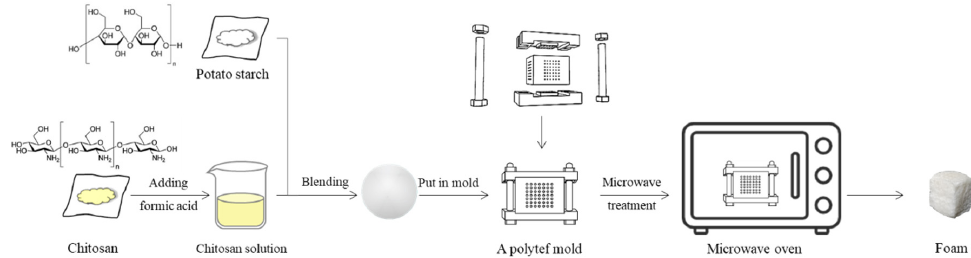
Figure 1. Schematic diagram of preparation of CTS-starch foams.